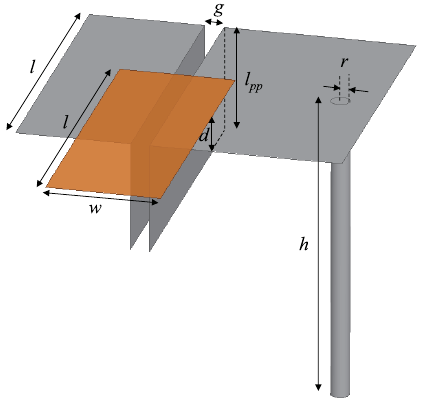
Fig. 9. Con fi guration of unit cell